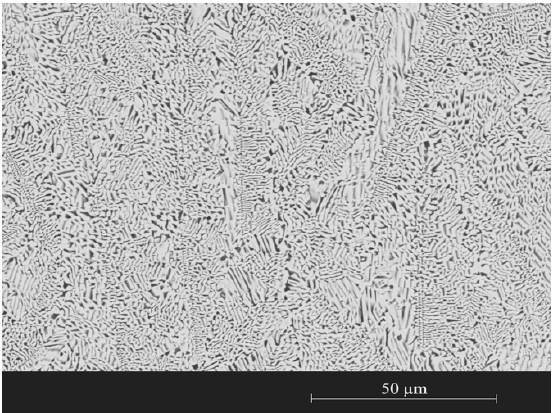
Figure 1. Secondary electron micrographs of the representative microstructure of eutectic alloy Si-62 wt% Ir.